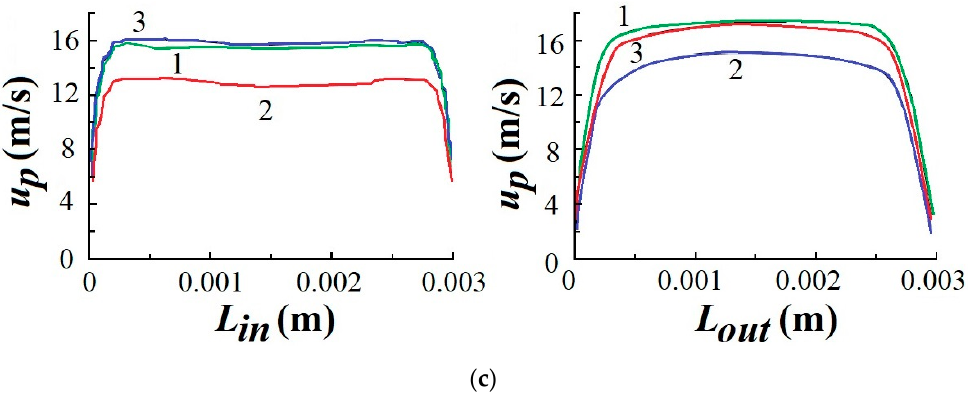
Figure 8. Change in total velocity u p for swirlers with straight channel walls along the reading line at the channel inlet L in and outlet L out at b = 0.003 (m), h = 0.008 (m), 𝑢(cid:3364) = 14 (m/s): ( a ) α = 26°; ( b ) α = 45°; ( c ) α = 90°. Lines (1–3) for reading by channel height h: 1— h = 0.004 (m); 2— h = 0; 3— h = 0.008 (m).